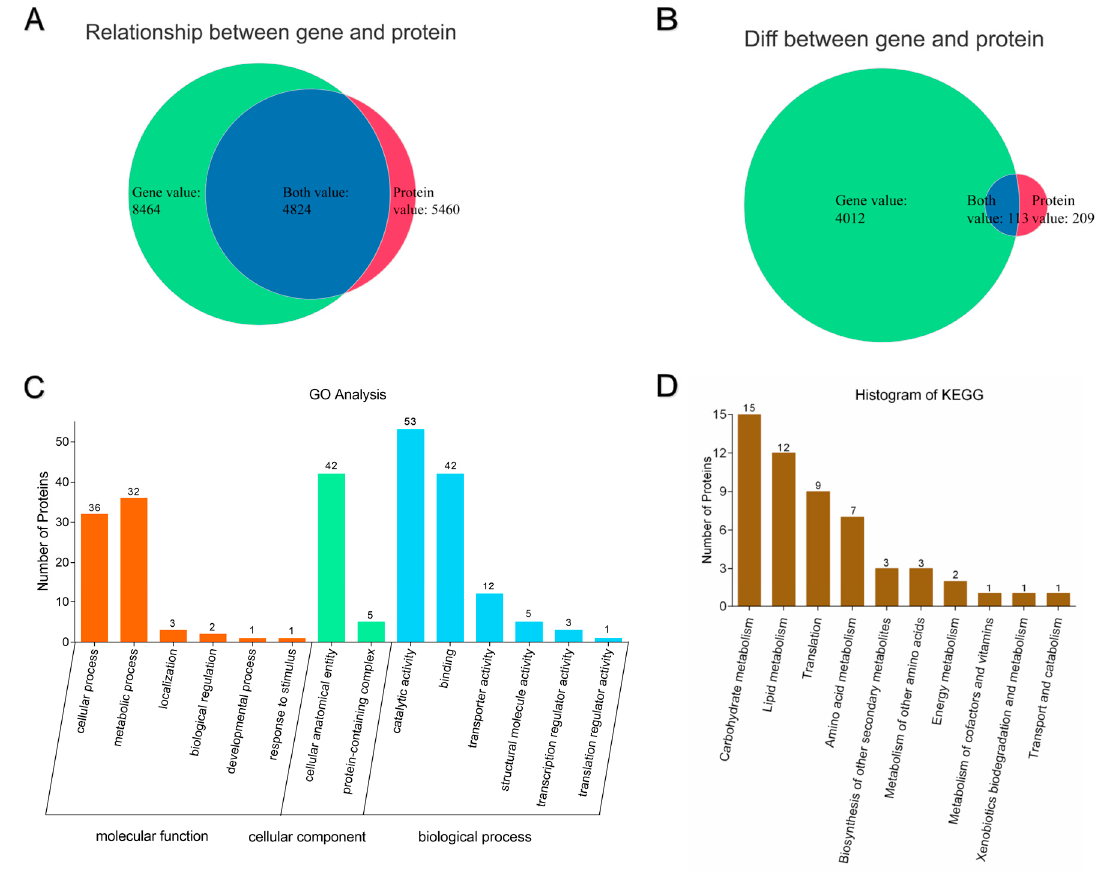
Figure 6. Combined analysis of transcriptomics and proteomics. The value of gene expression is significantly ( p < 0.05) differentially expressed (>2-fold), value of protein expression is significantly ( p < 0.05) differentially expressed (>1.5-fold) between two groups. ( A ) Venn of relationship between genes and proteins ( B ) Venn of matched differentially expressed genes and proteins ( C ) GO catego- rization of matched differentially expressed genes and proteins ( D ) Top 10 KEGG pathways of matched differentially expressed genes and proteins.